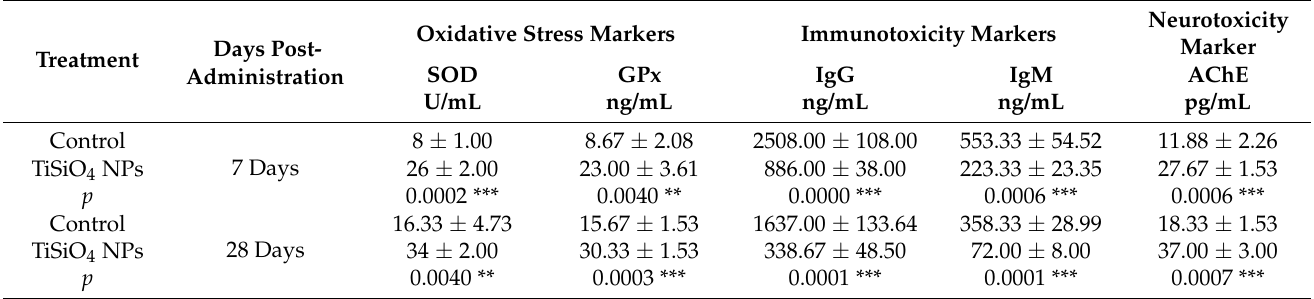
Table 2. Oxidative stress, immunotoxicity, and neurotoxicity in male rats exposed orally to 250 mg ≤ 50 nm TiSiO 4 NPs/kg b. w.